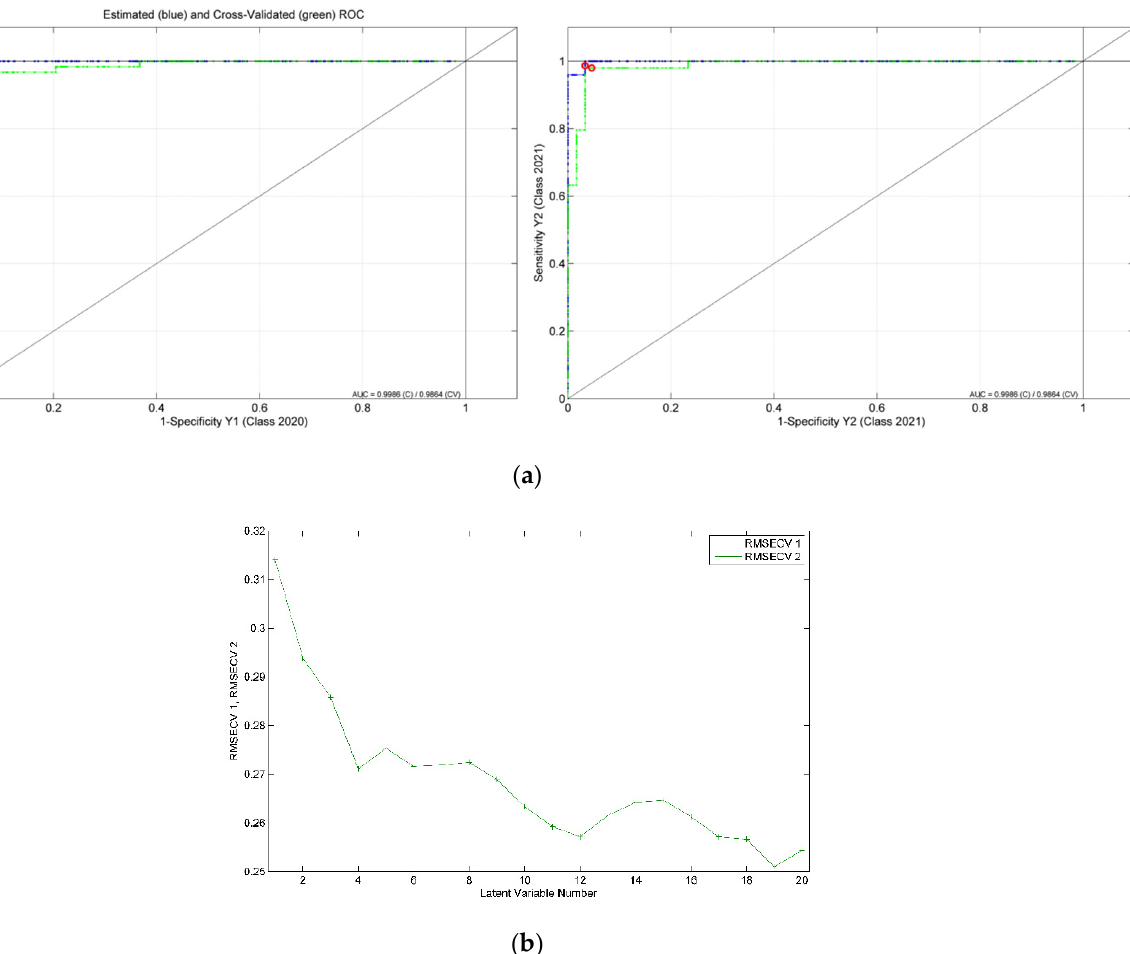
Figure 5. ( a ) ROC curves containing estimated (blue), cross-validated (green) values and model thresh- old (red circle), and ( b ) overlapped RMSECV plots for 2020 (RMSECV 1—blue) and 2021 (RMSECV 2—green) groups associated with the PLS-DA model developed for harvesting year